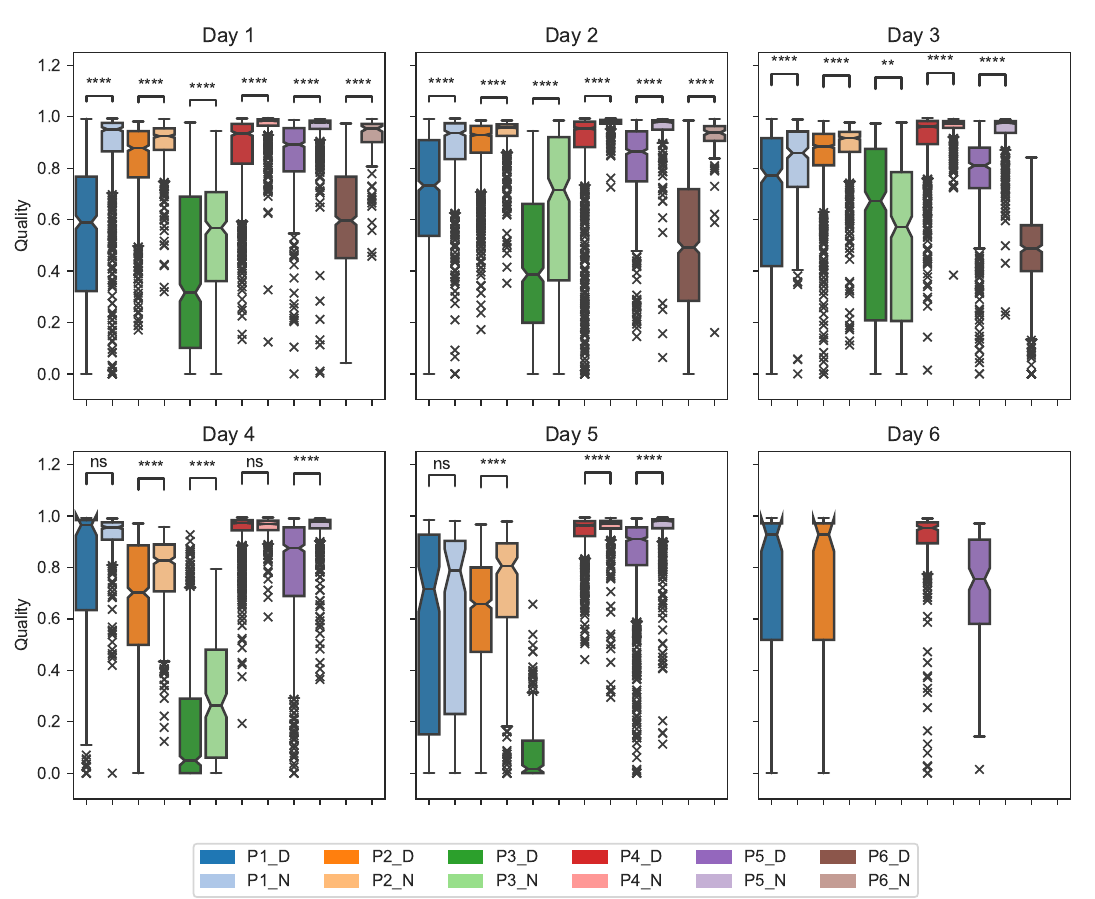
Figure 8. Distribution and statistical analysis of ECG quality during daytime and night for all patients.. The explanation of *, **, ***, **** and ns correspond to the definitions of Table 5.